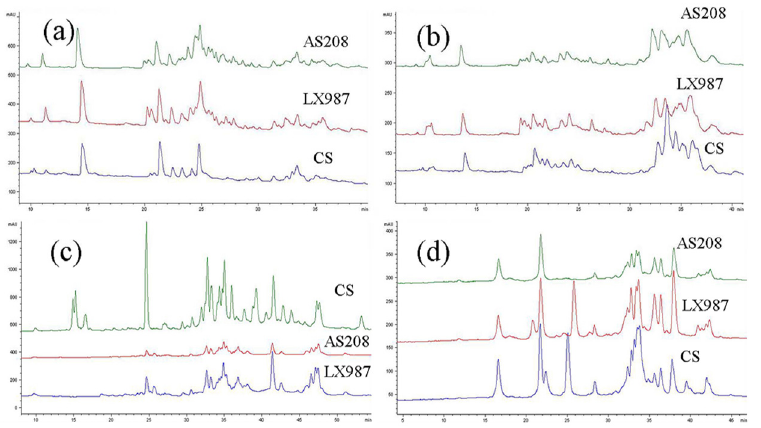
Fig 3. Identification of seed storage proteins in AS208, LX987, and CS by RP-HPLC. The peaks for albumin (a), globulin (b), and gliadin (c) in AS208 and LX987 were very similar, but were different from those of CS. However, the peak patterns for glutenin (d) were different among AS208, LX987, and CS, in which the three wheat accessions all had peaks for 1Dx2 and 1Dy12, while AS208 was missing peaks for 1Bx20 and 1By20 compared to its progenitor genotype LX987. The grains were harvested in Beijing in